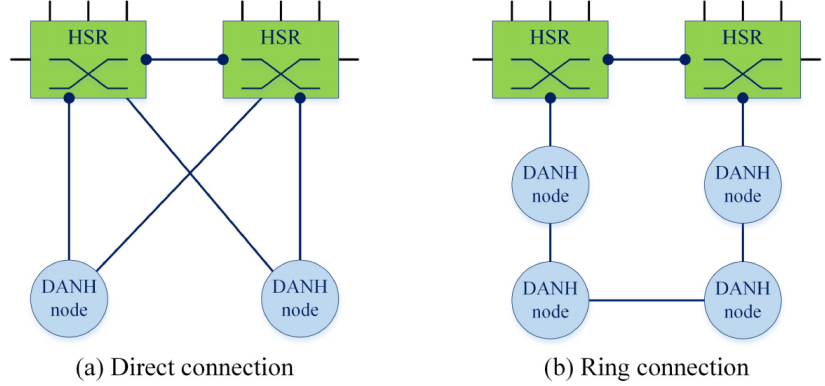
Figure 5. Types of connections between SwitchBoxes and HSR terminal nodes.